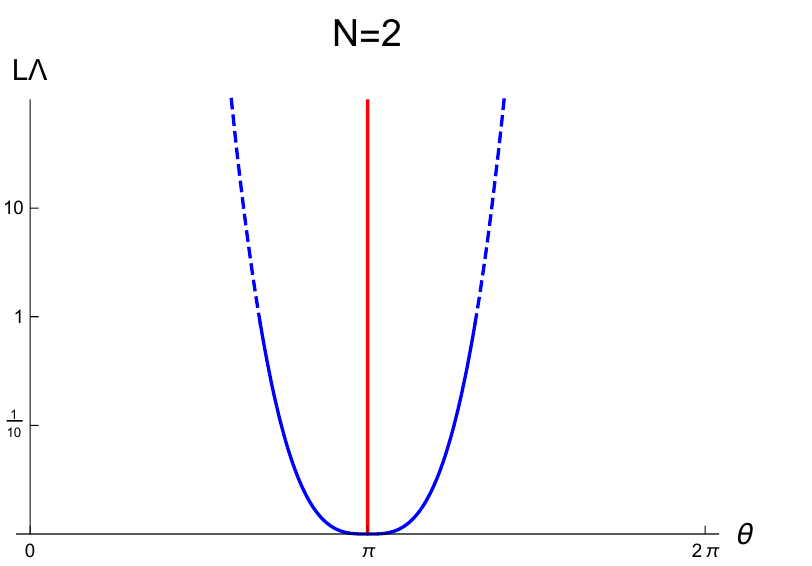
Figure 4 . [Color Online.] Spinodal curves (blue) and phase transition lines (vertical red line) for center-stabilized SU(2) YM theory in the L (cid:3)- (cid:18) plane. The vertical red line at (cid:18) = (cid:25) indicates a (cid:12)rst-order phase transition between two (cid:18) -vacua. The two blue curves mark the regions of spinodal instability of the (cid:18) -vacua, where a metastable branch reaches the limit of local stability. The behavior of the spinodal curves for L (cid:3) . 1 follows from (4.3) and (4.4), and hence is indicated by a solid curve, while the behavior for L (cid:3) & 1 is a conjecture and is indicated by the dashed portion of the dashed